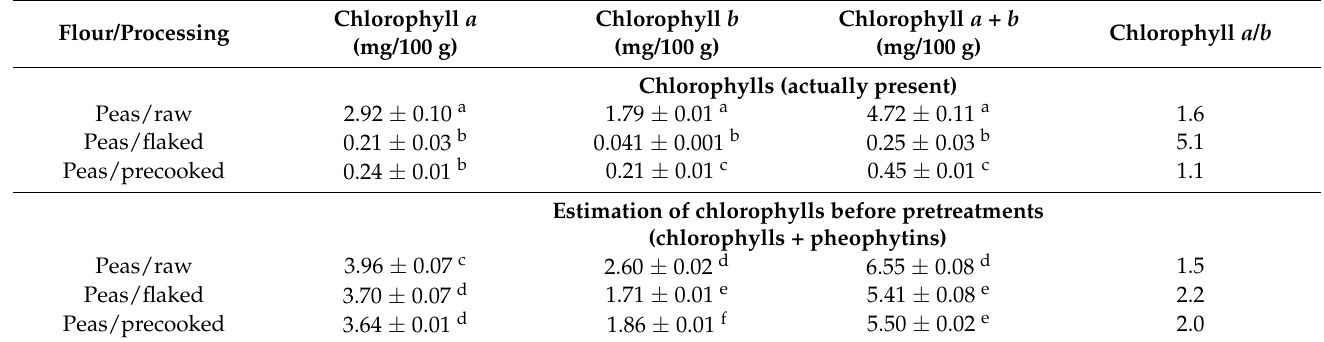
Table 7. Chlorophyll a , chlorophyll b , and total chlorophylls ( a + b ) in raw, flaked, and precooked pea flours, reported as mean ± SD ( n = 27). The chlorophyll a and b ratio is also